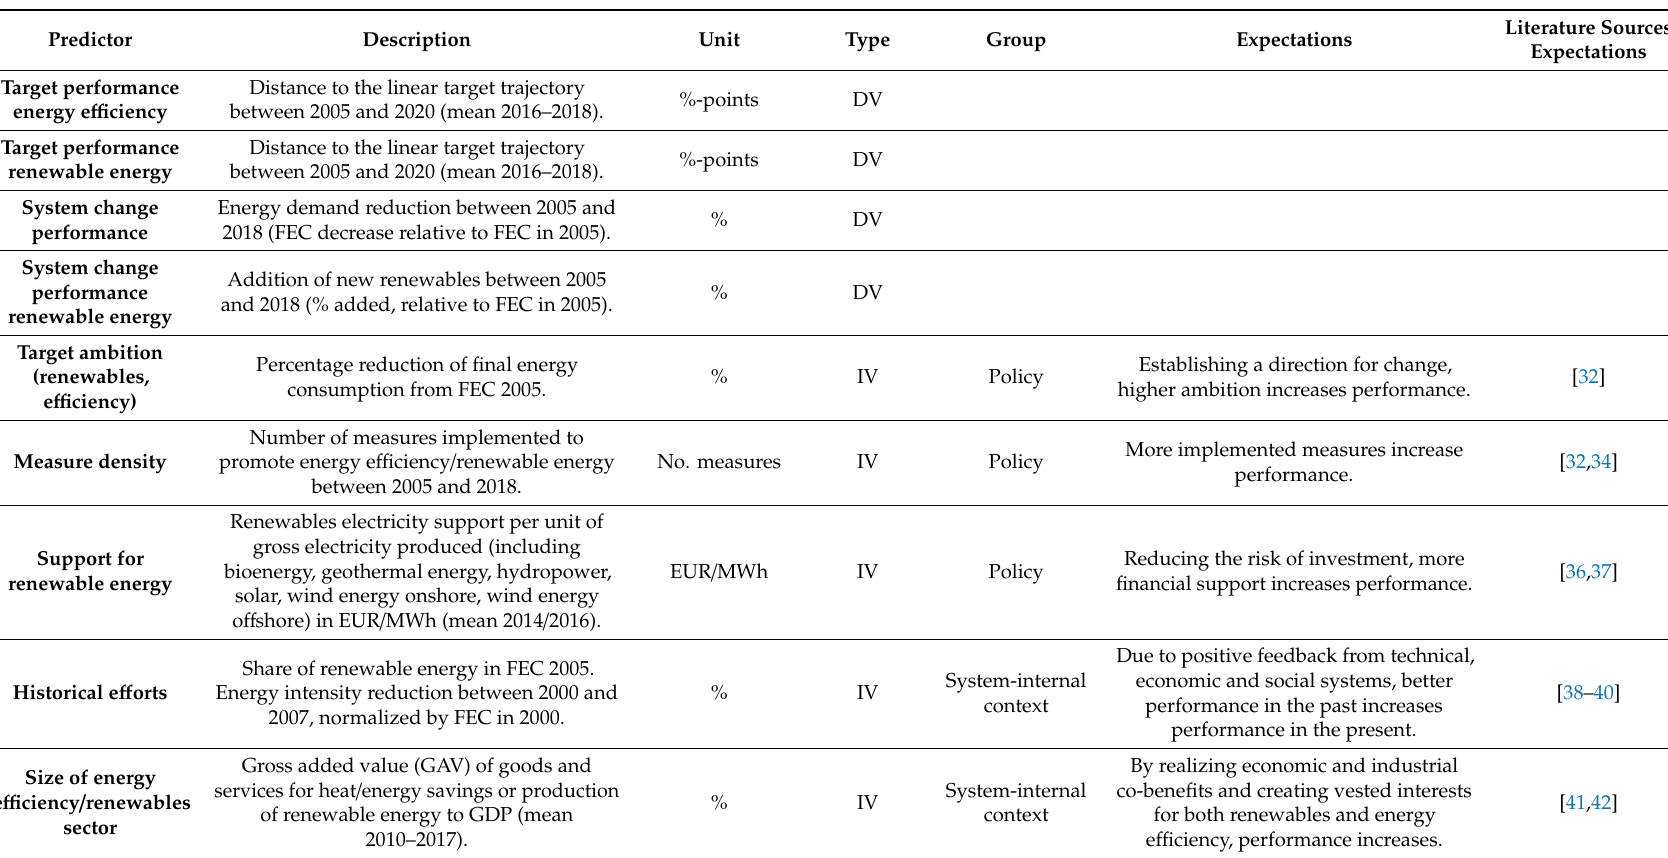
Table 2. Overview of policy output and socio-economic variables used in the MLR, their units and types in the model (DV = dependent variable, IV = independent variable). Expectations describe the expected relationship between IV and DV for both energy e ffi ciency and renewable energy. Description Unit Type Group Expectations